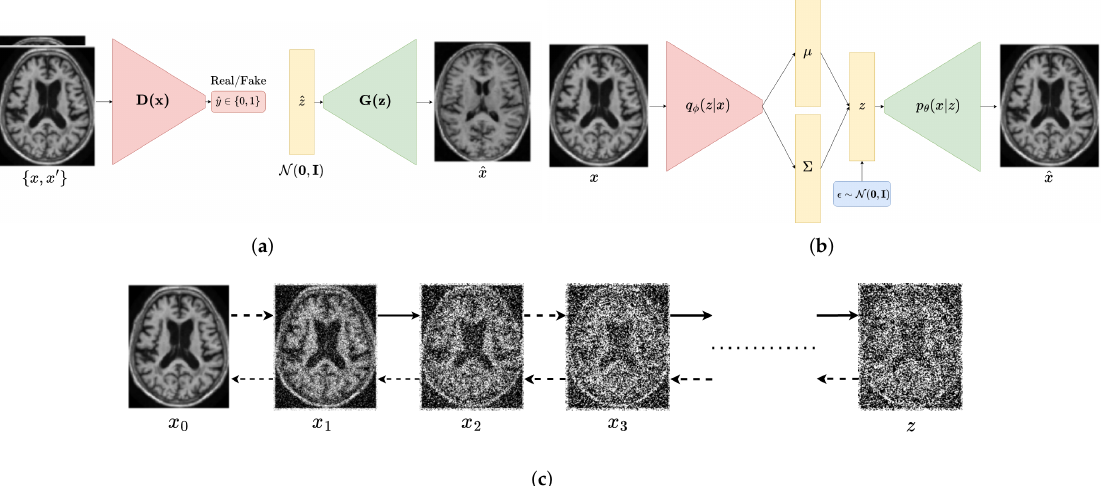
Figure 2. Illustration of the three deep generative models that are commonly used for medical image augmentation: ( a ) generative adversarial networks (GANs), which consist of a generator and a discriminator network trained adversarially to generate realistic data; ( b ) variational autoencoders (VAEs), which consist of an encoder and a decoder network trained to reconstruct data and learn a compact latent representation; and ( c ) diffusion models, which consist of a forward and backward flow of information through a series of steps to model the data